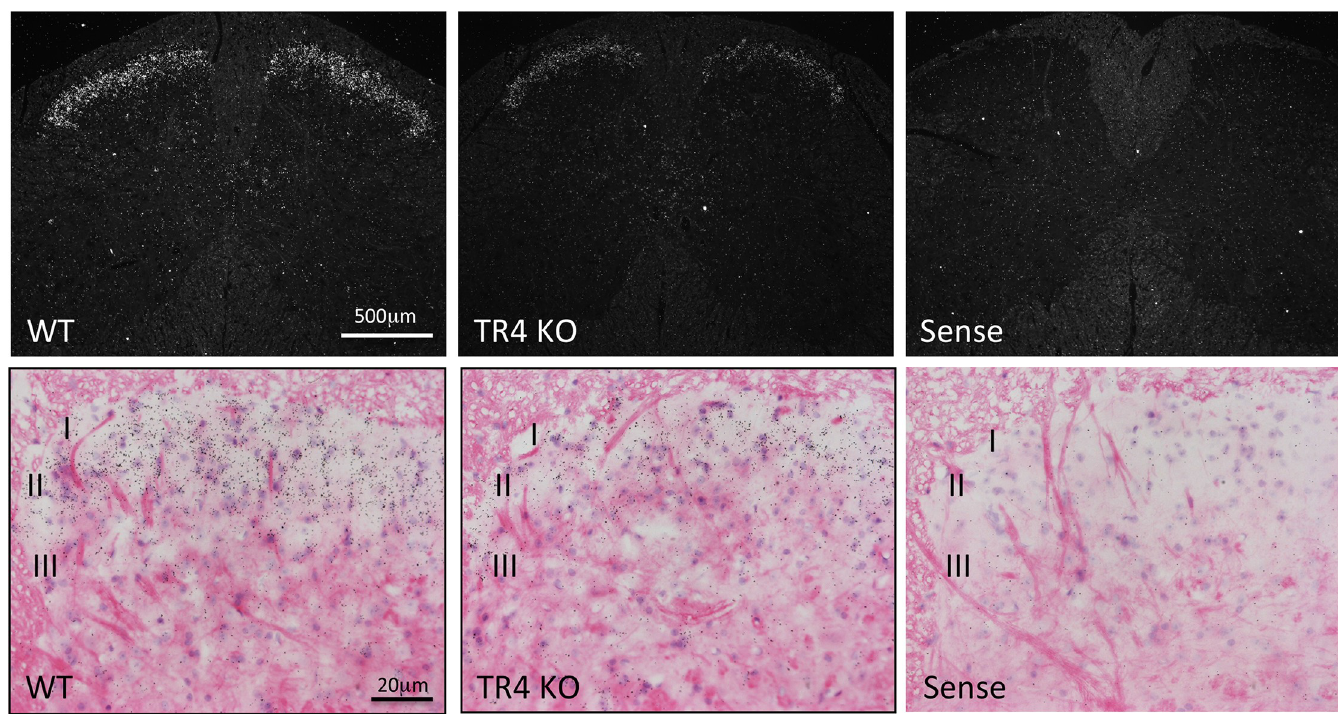
Fig 1. Hippocalcin-like 4 (Hpcal4) expression in the spinal cord of na ï ve and TR4 mutant mice. Darkfield (Top) and brightfield (bottom) panels illustrate situ hybridization expression patterns of Hpcal4 mRNA in the lumbar spinal cord of na ï ve (WT) and TR4 mutant (KO) mice. Hpcal4 is predominantly expressed in the substantia gelatinosa (laminae I-II) in na ï ve mice but strongly reduced in the spinal cord of TR4 mutant mice.